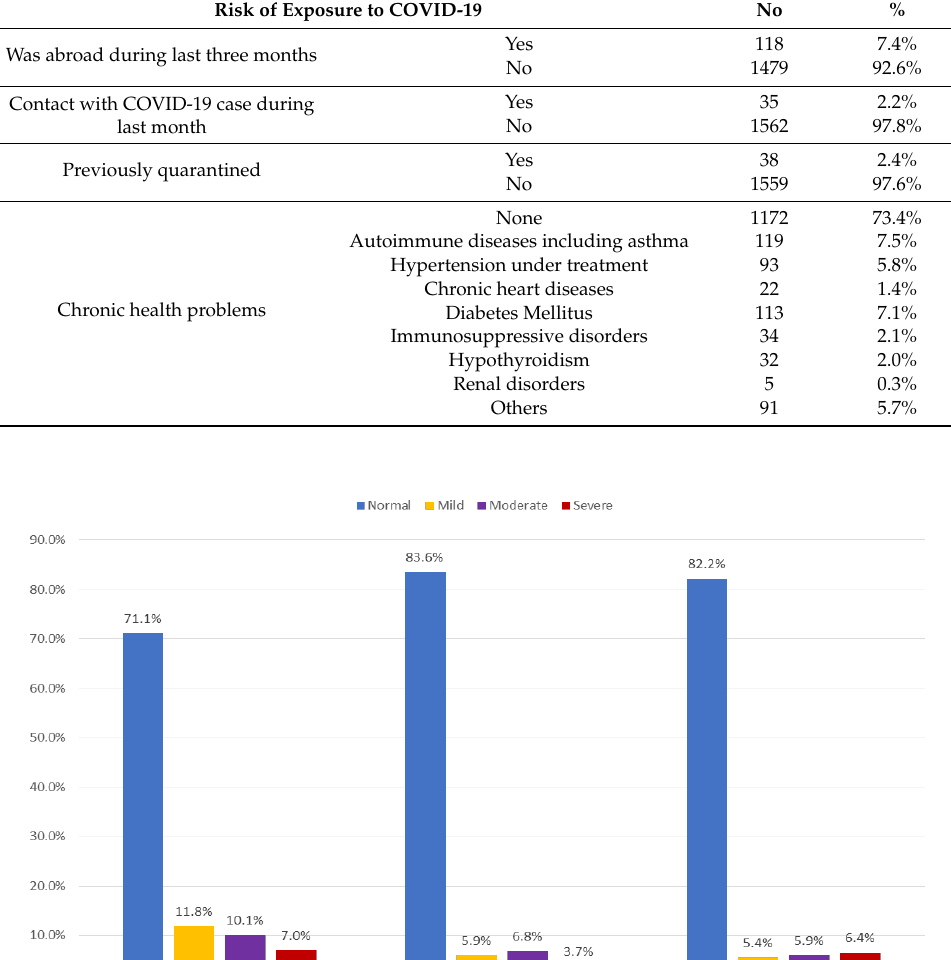
Table 3. Risk of exposure to COVID-19 among survey participants.